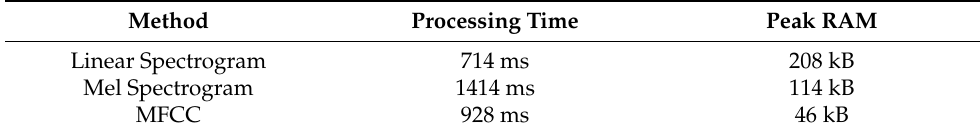
Table 2. Performance comparison adopting different pre-processing